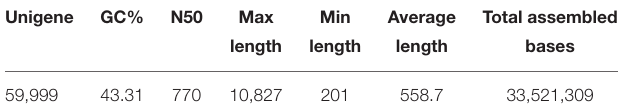
TABLE 2 | Results of de novo assembly.